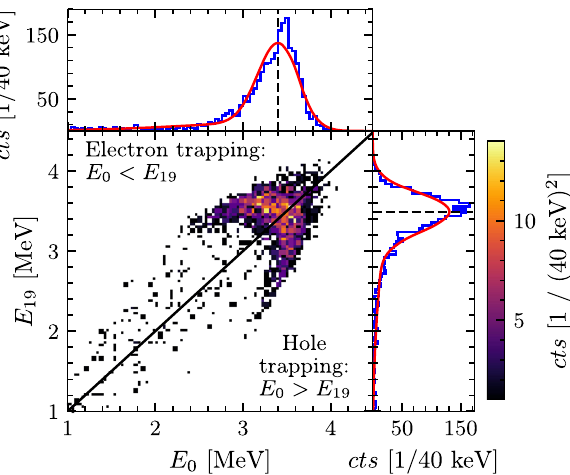
Fig. 13 Correlation between core and segment 19 energies of alpha events selected as described in Sect. 3 from a measurement of the scan ASTat ϕ = 232 . 9 ◦ and r = 23 . 8mm.Alsoshownarethetwomarginal- isations. The dashed (black) lines mark the position of the parameter / 19 E 0 μ, j , obs for this measurement j of the respective fitted function Eq. (4), shown as a solid (red)